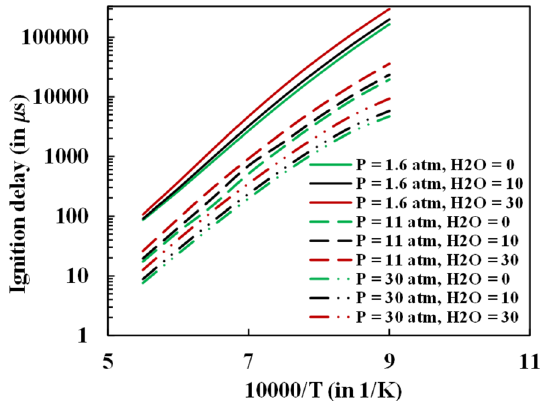
Figure 7. Ignition delay comparison with steam dilution (0%, 10% and 30%) and pressure (1.6, 11 and 30 atm).